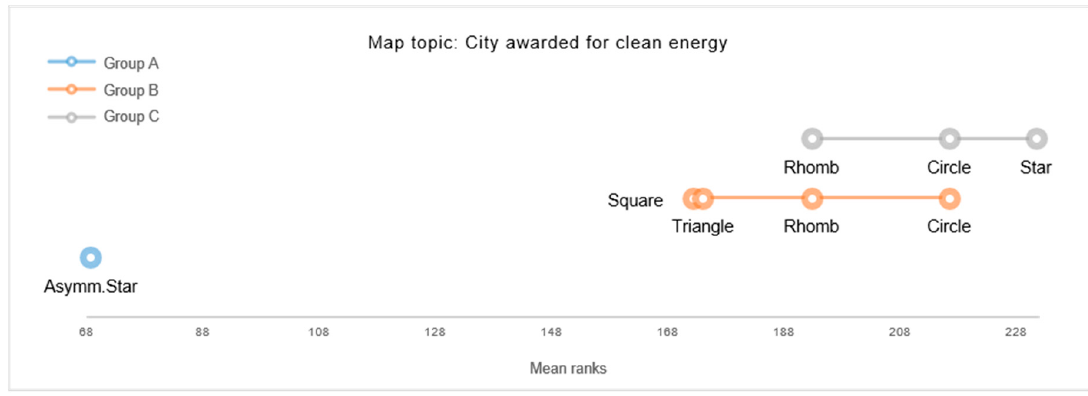
Figure 5. Map #1: Results of multiple pairwise comparisons, indicating groups of (dis)similar symbol-content congruence.